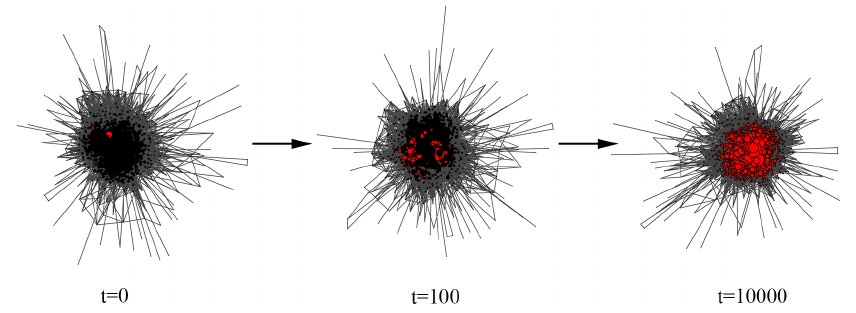
Figure 6. The evolution of cooperation in Facebook dataset 1 with denoting only two pairs of best friends (four cooperators) as cooperators initially. The size of each node is related to its degree. Red nodes represent cooperators and black nodes represent defectors. We set b ~ 20 , c ~ 1 and a ~ 20 . The game is repeated for 10000 times. The fraction of cooperators becomes 1 after 2000 time